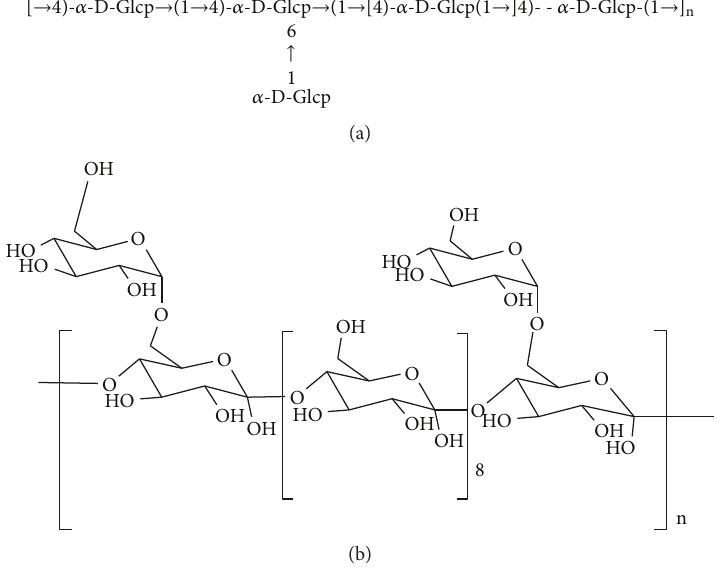
Figure 10: Molecular structure of APS. (a) Chain structure; (b) skeleton